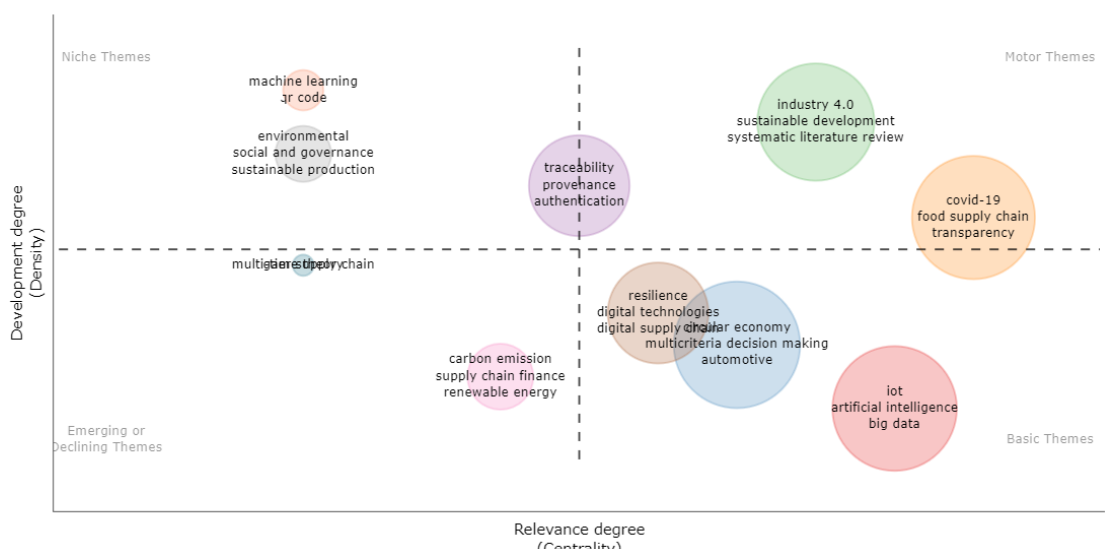
Figure 8. Thematic Map (2022).